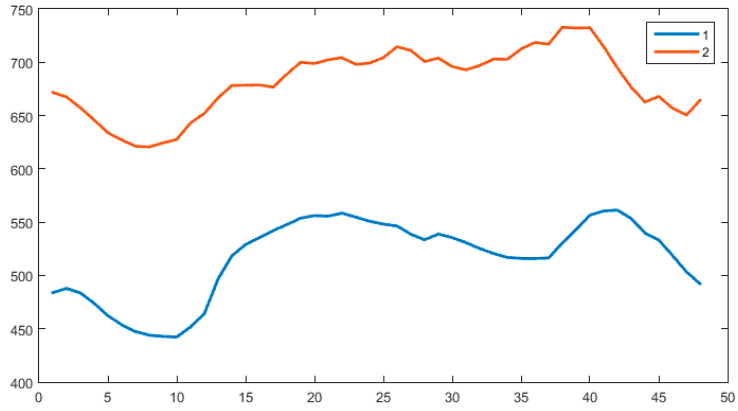
Figure 5. Typical load curve from Figure 4 (blue for cluster 1, and red for cluster 2).